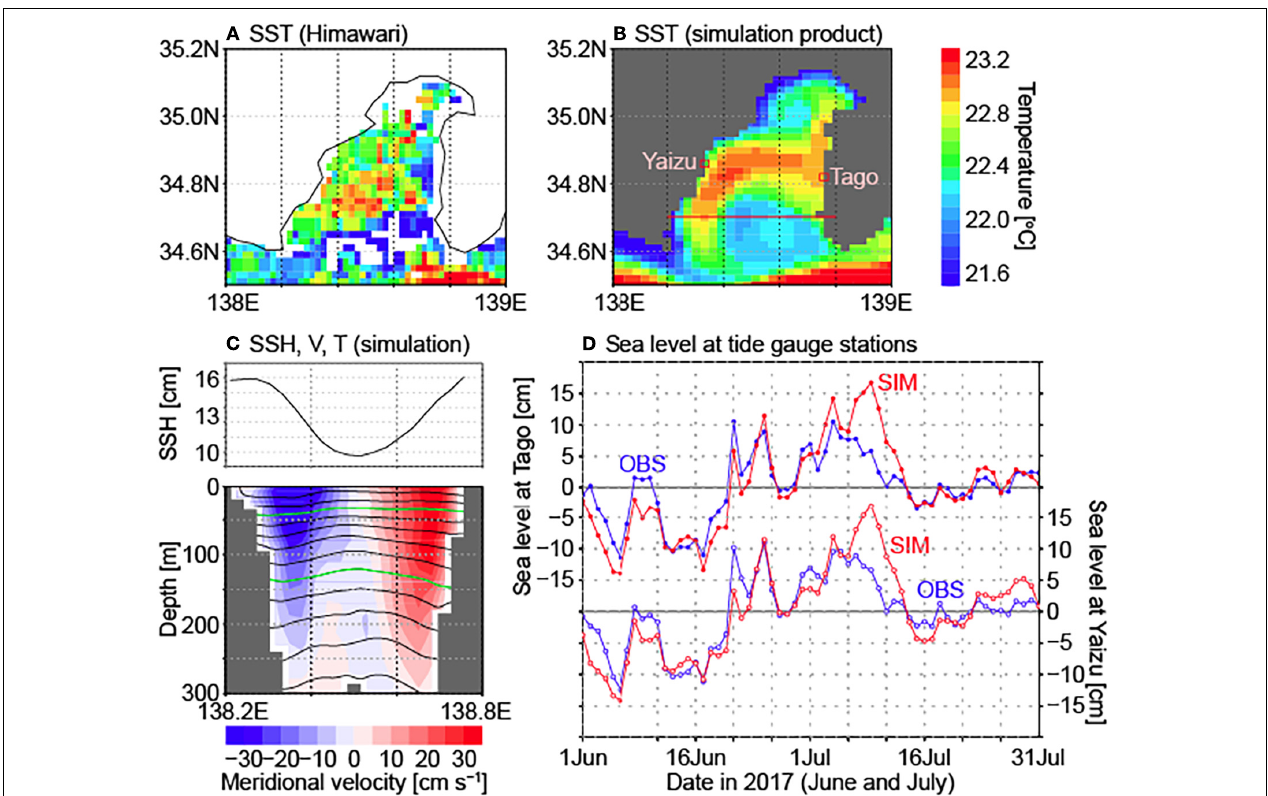
FIGURE 9 | (A) Distribution of SSTs derived from satellite (Himawari-8) observations on 29 June 2017. Missing values are due to cloud cover flags. (B) Same as (A) but from the simulation product. (C) Distributions of SSHs (upper panel), meridional velocities (shading in lower panel), and potential temperature (contours in lower panel with 1 ◦ C intervals; green contours indicate 15 and 20 ◦ C) along the 34.7 ◦ N zonal line [red line in (B) ]. (D) Daily time series of sea levels at the tide-gauge stations [red rectangles in (B) ], Tago (138.76 ◦ E, 34.81 ◦ N; closed circles; left axis) and Yaizu (138.33 ◦ E, 34.87 ◦ N; open circles; right axis), in June and July 2017. Blue and red lines indicate tide-gauge observation data and the simulation product, respectively. Note that these time series include the effect of surface